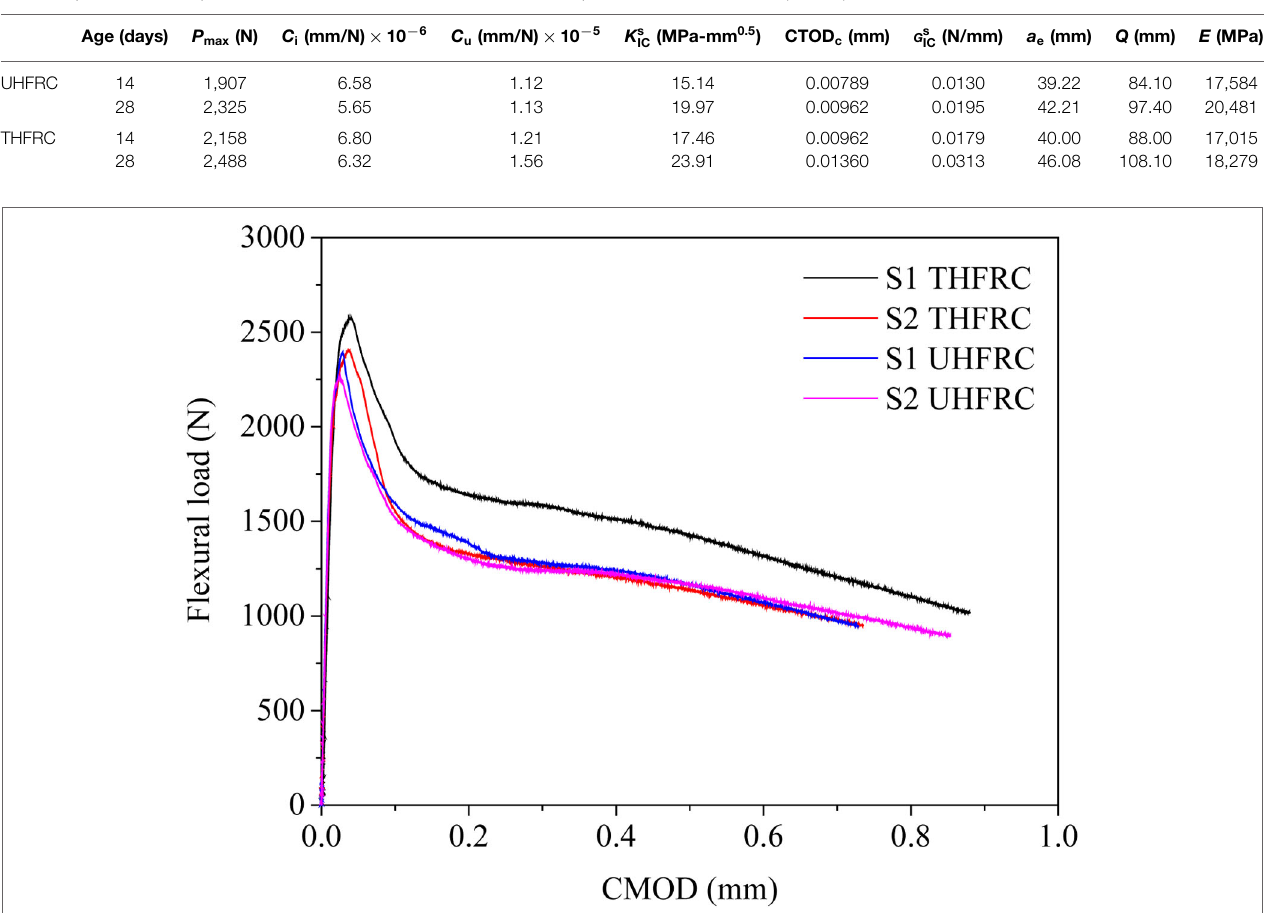
TABLE 2 | Results for two parameter fracture test of UHFRC and treated hemp fiber-reinforced concrete (THFRC).